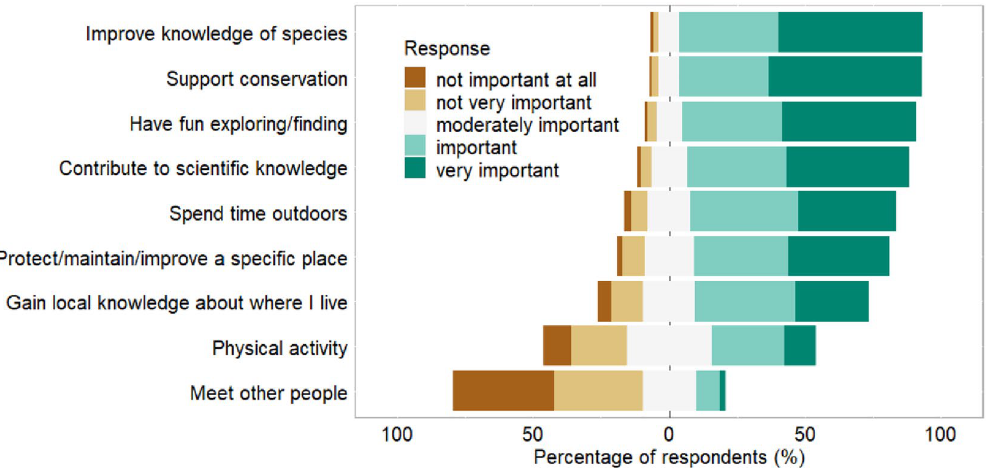
Figure 1. Motivations of respondents to collect species observation data. Respondents were asked to rate the importance of each item. Items are ordered in the plot by the % responding ‘important’ or ‘very